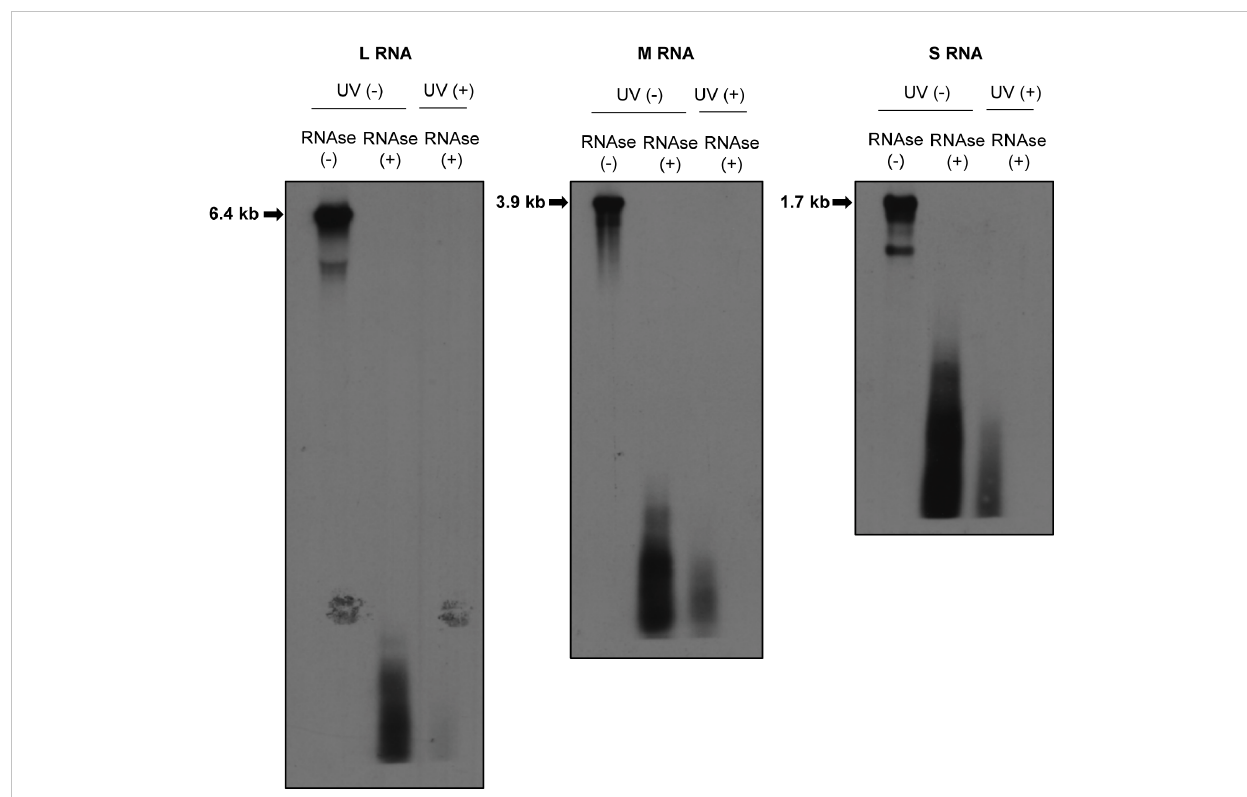
FIGURE 2 Susceptibilities of RVFV RNPs to RNAses. Huh7 cells were infected with RVFV at an MOI of 3 and mock-irradiated (UV -) or irradiated with UV light (UV +) at 8 h p.i. Cell extracts were prepared and treated with RNAse A/T1 mixture (RNAse +) for 3 h at 37 ˚ C. After RNAse digestion, viral RNAs were extracted and subjected to Northern blot analysis using digoxigenin-labeled RNA probes, each of which speci fi cally binds to genomic L (left panel), M (middle panel) or S RNA (right panel). Strong RNA signals indicated by arrows in the RNAse-untreated samples represent the viral genomic